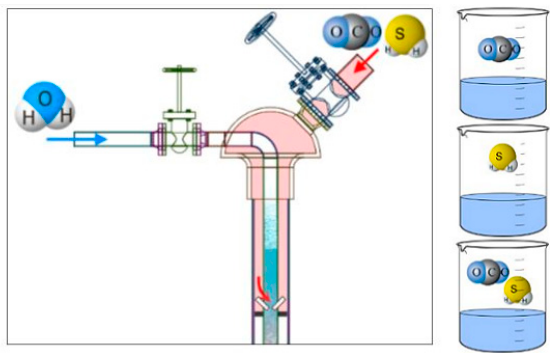
Figure 1. Schematic of the reinjection well and the process of non-condensable gas (NCG) injection into the downward flowing water.